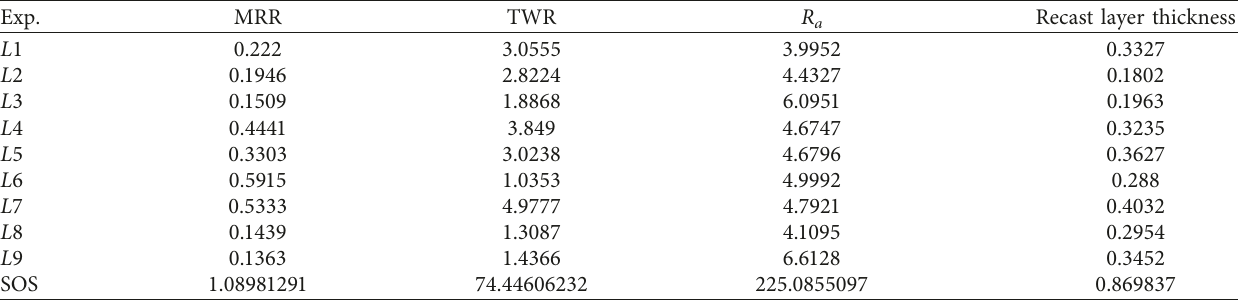
Table 13: Determination of performance matrix.